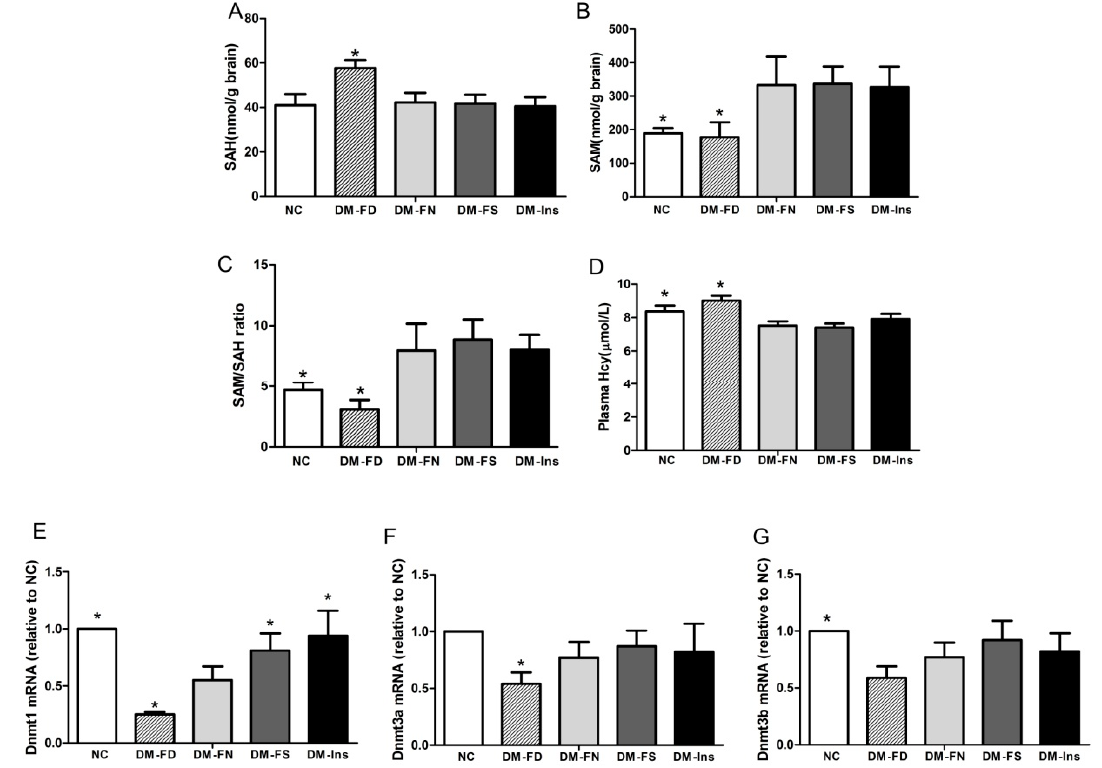
Figure 4. Influence of folic acid on methyl potential and DNMT mRNAs expression in STZ-treated mouse brains. Concentration of brain SAH ( A ), SAM ( B ) and plasma HCY ( D ) were determined by HPLC. SAM:SAH ratio ( C ) is generally considered to be a good indicator of DNA methylation potential. Gene expression of DNMT1 ( E ), DNMT3a ( F ) and DNMT3b ( G ) were measured by real-time PCR. The data were expressed as means ± SD values, n = 6 animals/group. * p < 0.05 versus the DM-FN group. DNMT, DNA methyltransferase; SAM, S-adenosyl methionine; SAH, S-adenosyl homocysteine; HCY, homocysteine.